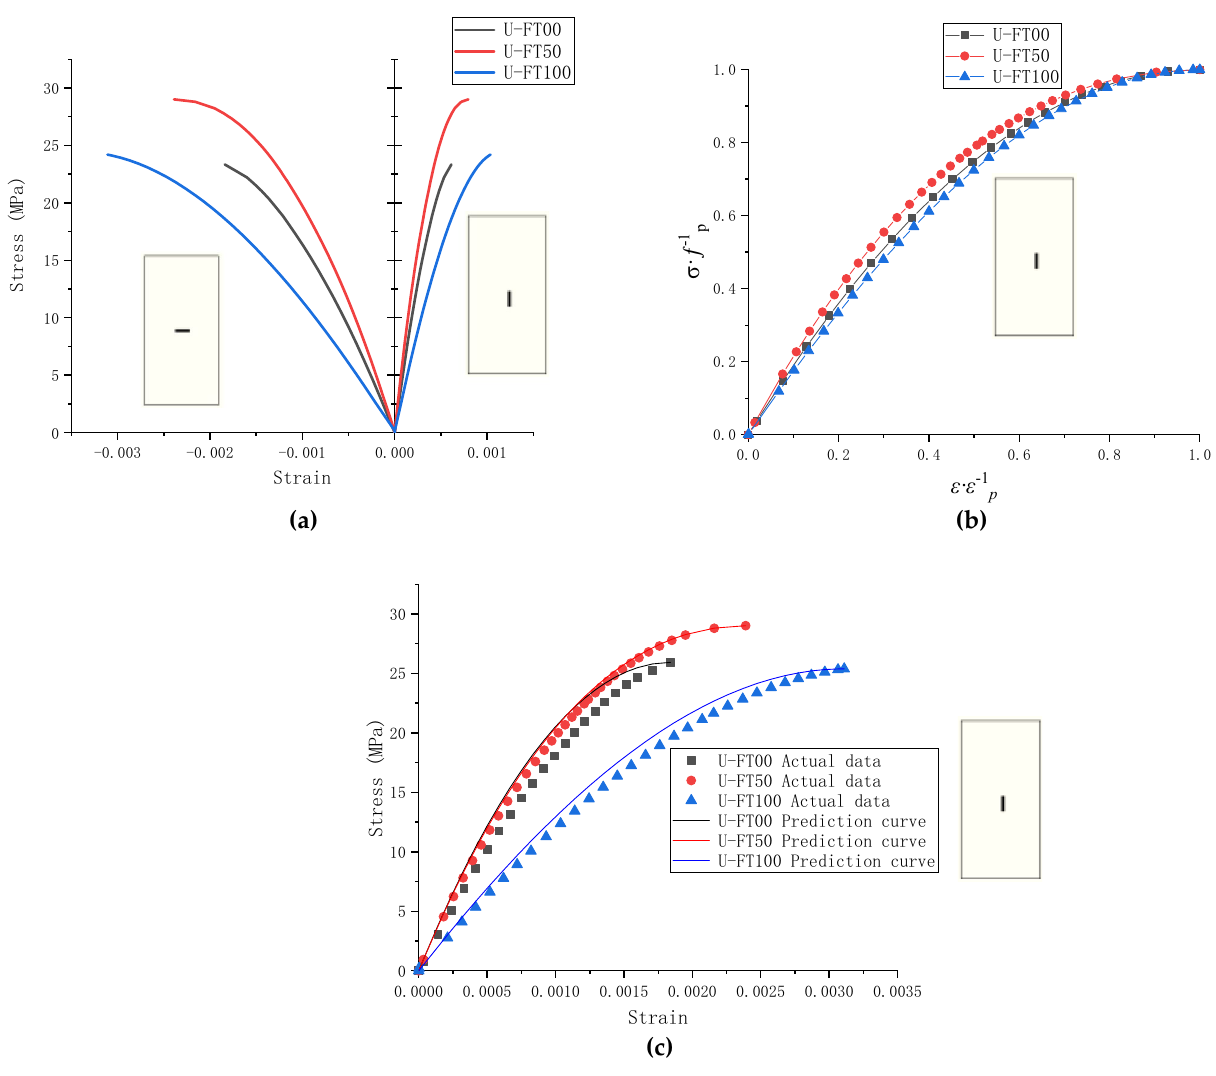
Figure 12. Unconfined concrete stress–strain curve: (a) measured stress–strain curve ; (b) Guo Zhenhai’s dimensionless stress–strain curve; (c) measured and fitted stress–strain